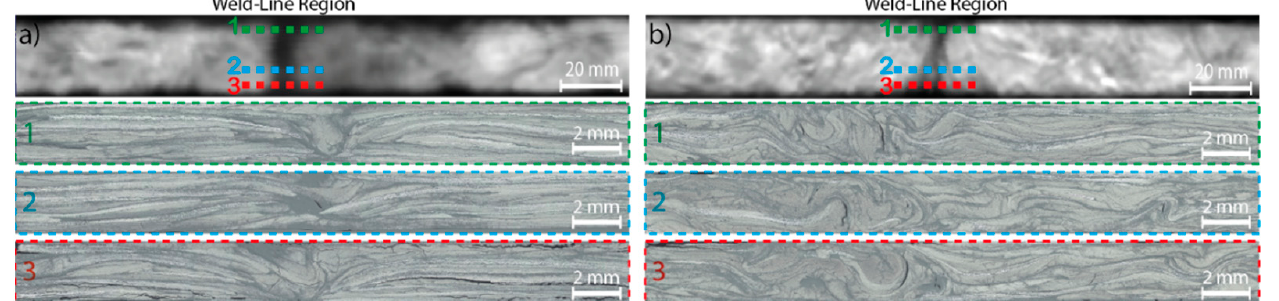
coupon (top) and three successive through-thickness (out-of-plane) optical micrographs from the